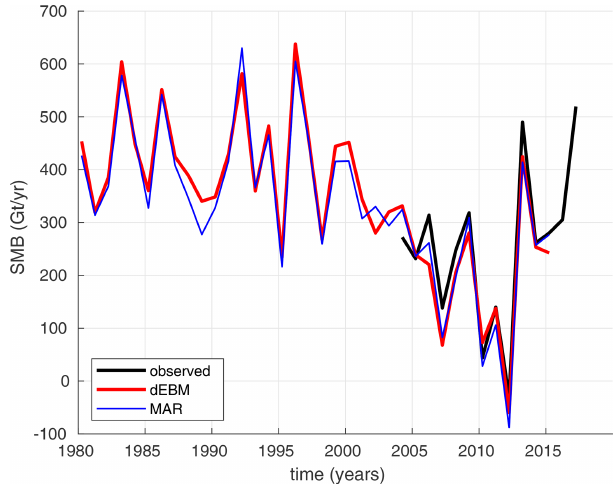
Figure 6. Annual mean integrated SMB inGtyr − 1 of the Green- land Ice Sheet as derived from integral observations (black), and as simulated by MAR (blue) and dEBM (red).